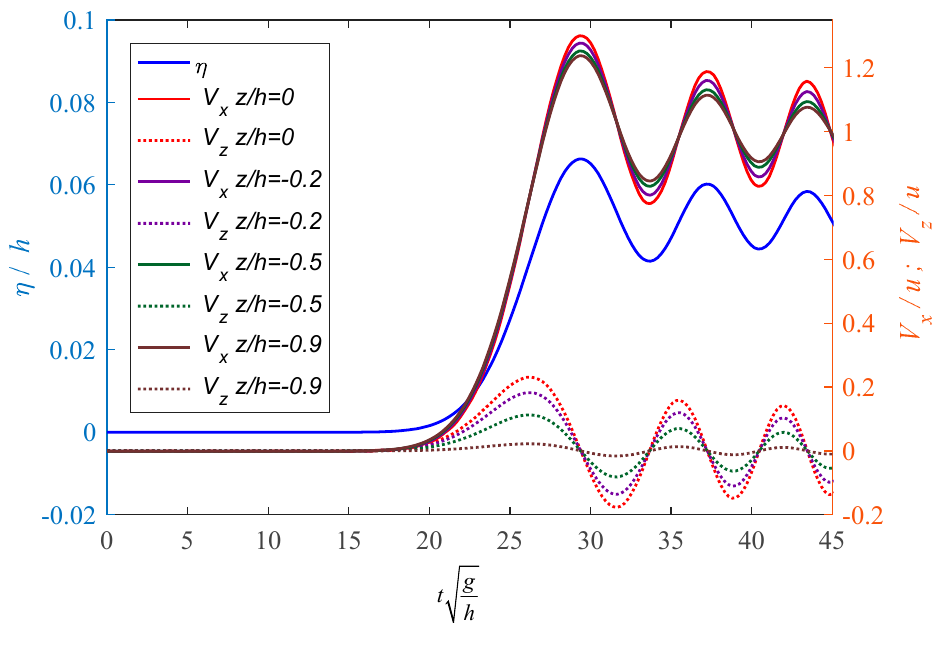
Figure 7. Variation of horizontal and vertical velocities at different depths.